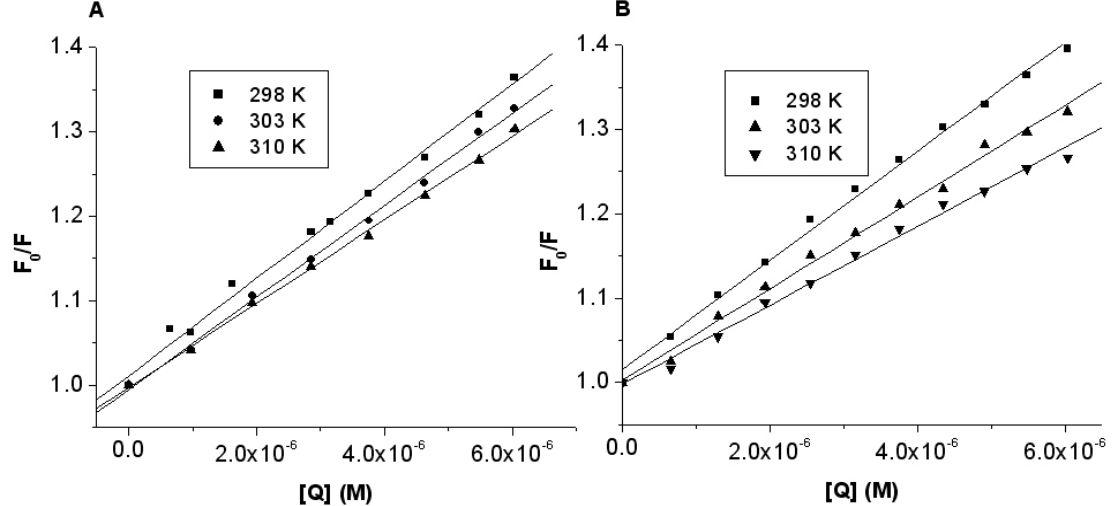
Figure 3. Stern-Volmer plots at different temperatures for A) [HSA]= 0.75×10 -6 (M); B) [BSA]= 0.75×10 -6 (M); d/p=0-8.03; pH